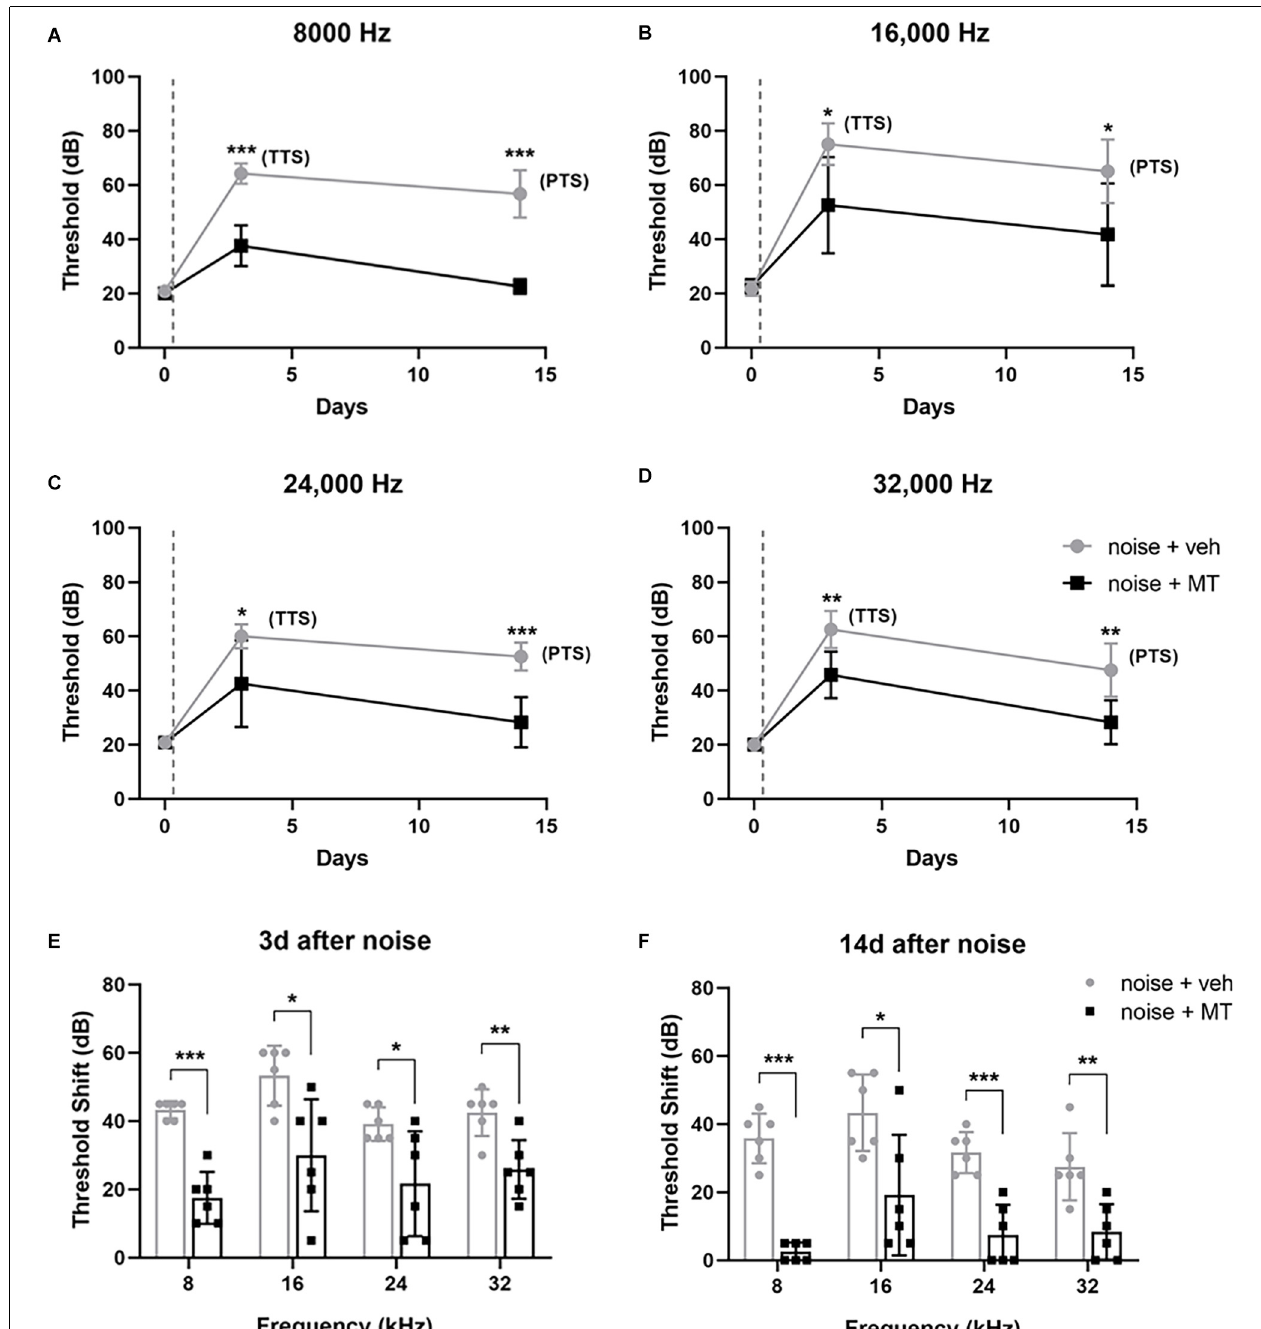
FIGURE 2 | MT treatment attenuated noise-induced auditory threshold shifts. (A–D) The auditory threshold alterations of the left ear of animals at 8, 16, 24 and 32 kHz over time. The baseline threshold, TTS, and PTS were evaluated before, 3d after and 14d after the noise exposure respectively. (E,F) The auditory threshold shifts over four frequencies on the day 3 and the day 14. The gray dotted lines indicate the time of acoustic trauma. Data are presented as means ± SD, n = 6 for each group, * p < 0.05, ** p < 0.01, *** p < 0.001. MT, mito-TEMPO; TTS, temporary threshold shift; PTS, permanent threshold shift.